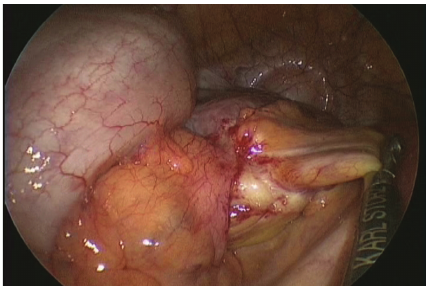
Figure 2: Intraoperative finding 1: the ileum herniated into the intersigmoid fossa. Mild adhesions of herniated ileum at the hernial orifice were observed.